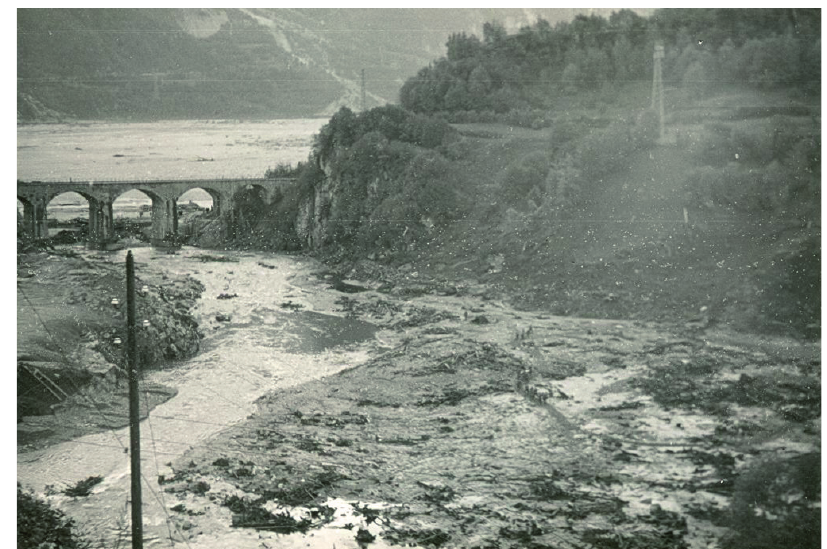
Figure 4. The Maè Torrent at the bottom of the Piave valley, south of Longarone village.